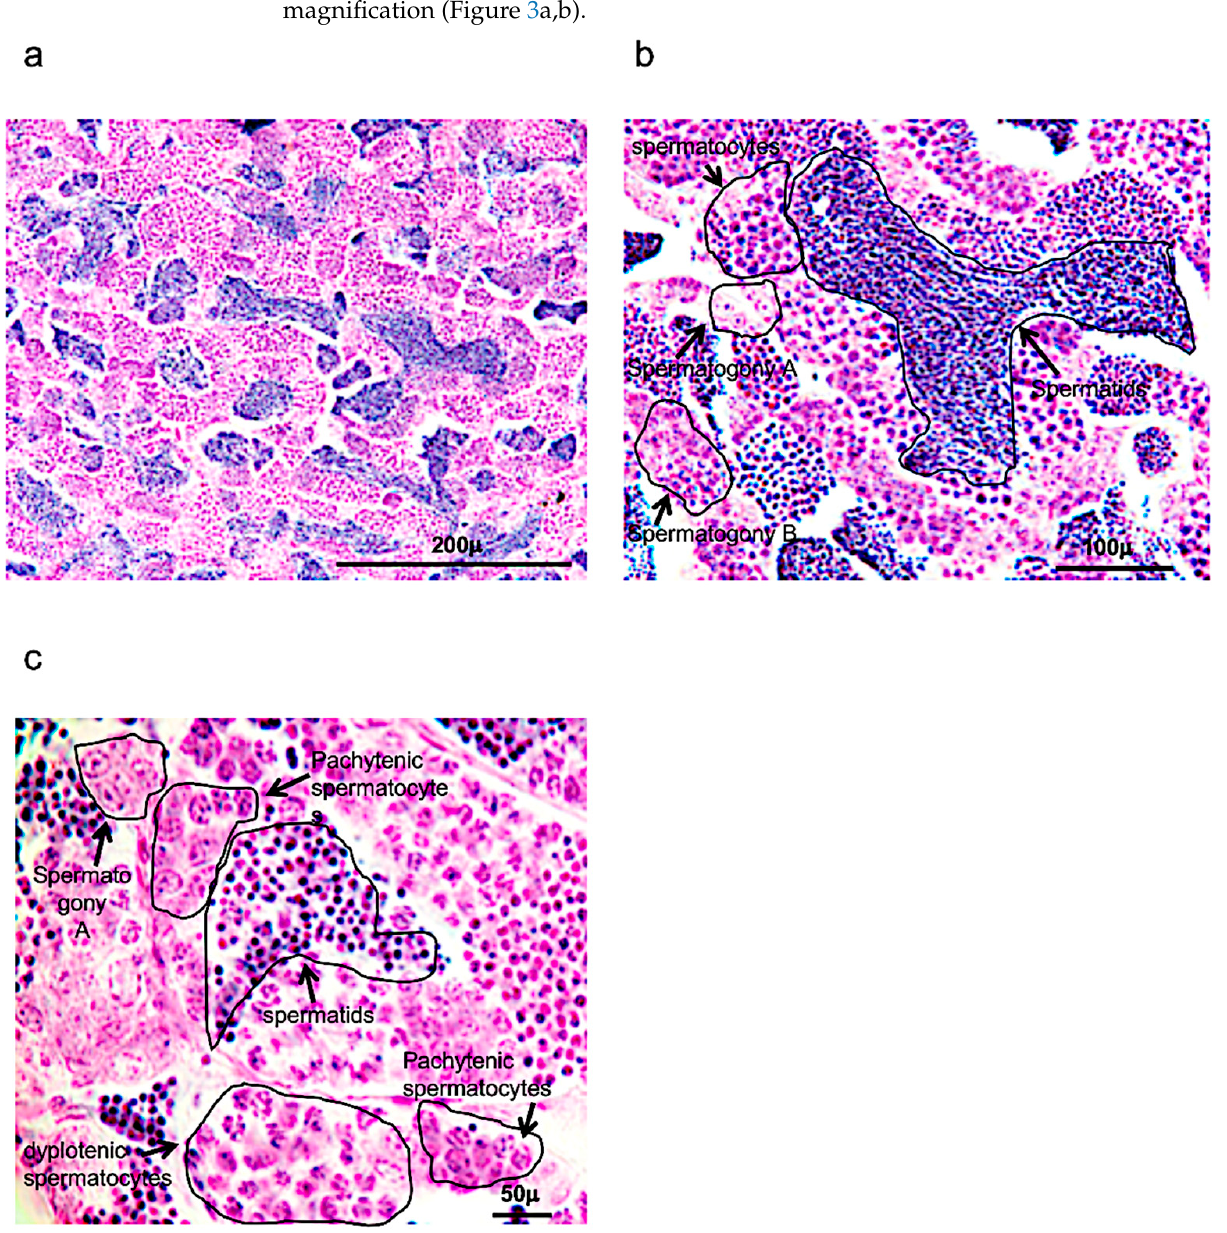
Figure 1. Hematoxylin-eosin staining of adult zebrafish testis. ( a ) Overview of adult zebrafish testis by hematoxylin-eosin staining. ( b ) Spermatogony A-B, spermatocytes and spermatids in adult zebrafish testis by hematoxylin-eosin staining. ( c ) High magnification of spermatogony A, spermatocytes (different phases of meiosis) and spermatids in adult zebrafish testis by hematoxylin-eosin staining. Scale bars are: 200 µ ( a ); 100 µ ( b ); and 50 µ ( c ). Concerning the receptor trka, it was expressed in three different cell populations: sper- matogony type A, B and dyplotenic spermatocytes of adult zebrafish testis (Figure 4a–f). These results were confirmed by using confocal microscopy with high magnification (Figure